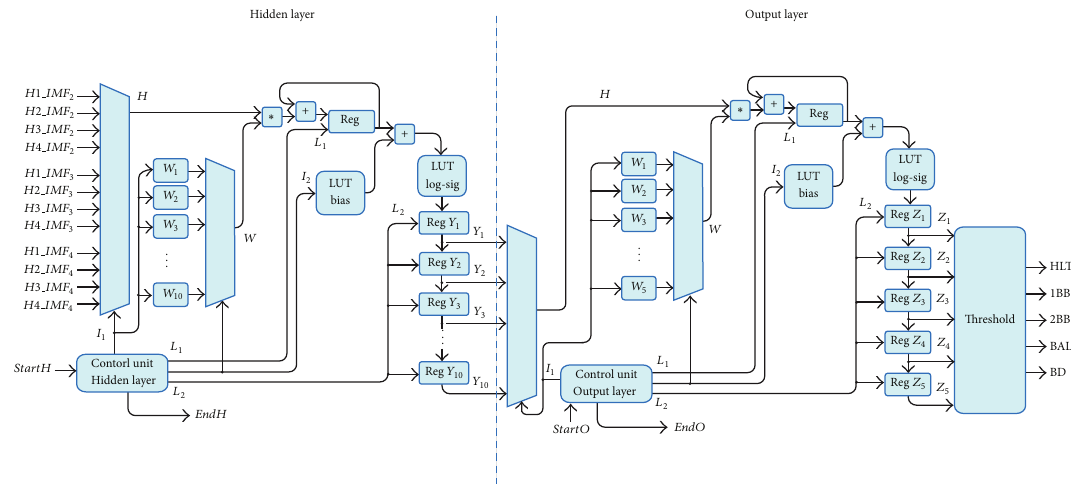
Figure 13: Block diagram of the FFNN module: (a) hidden layer, and (b) output layer.